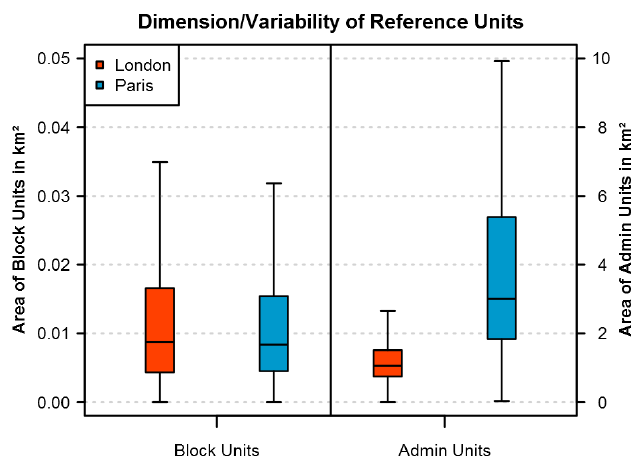
Figure 7. The influence of varying grid sizes on density measures calculated for gross densities.